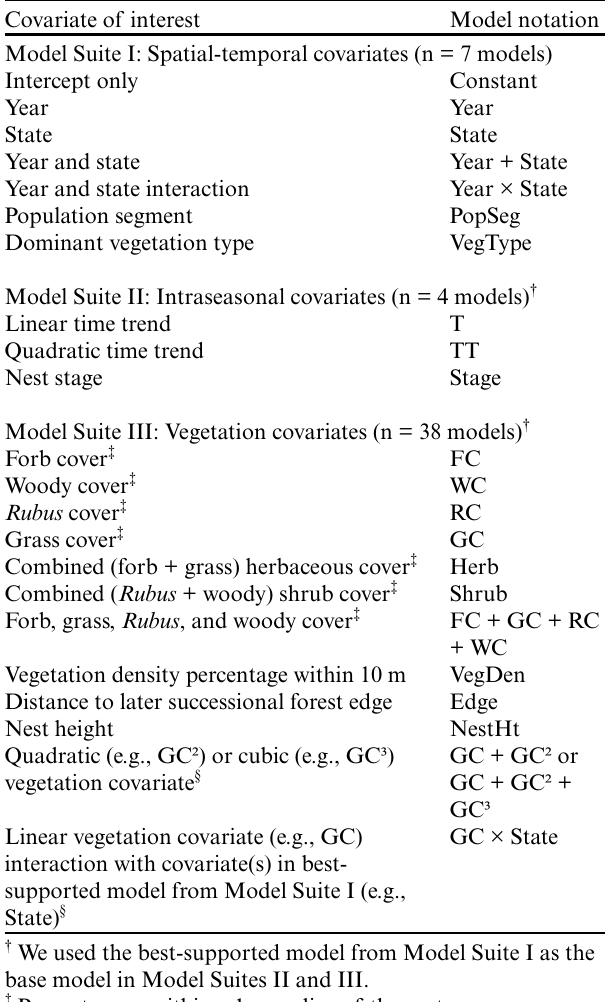
Table 2 . Definitions and notation of all candidate models used in model suites for evaluating the association of spatial-temporal (Model Suite I), intraseasonal (Model Suite II), and vegetation (Model Suite III) covariates with daily survival rate of Golden- winged Warbler ( Vermivora chrysoptera ) nests using program MARK (ver. 7.1, Colorado State University, Ft. Collins, Colorado, USA).